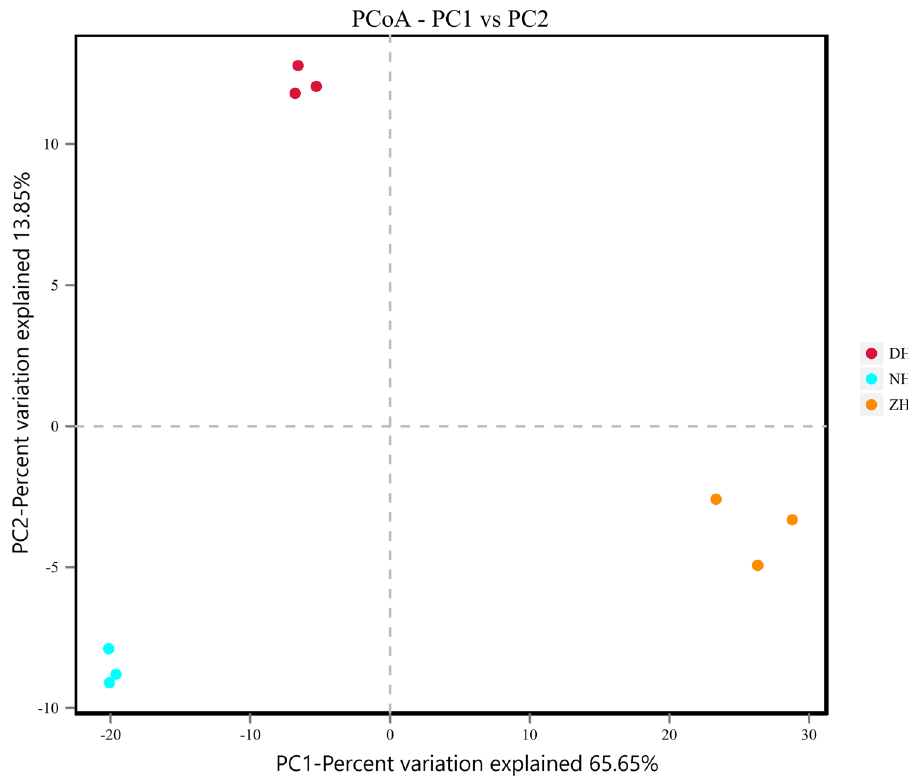
Figure 3. PCoA based on unweighted unifrac distance.